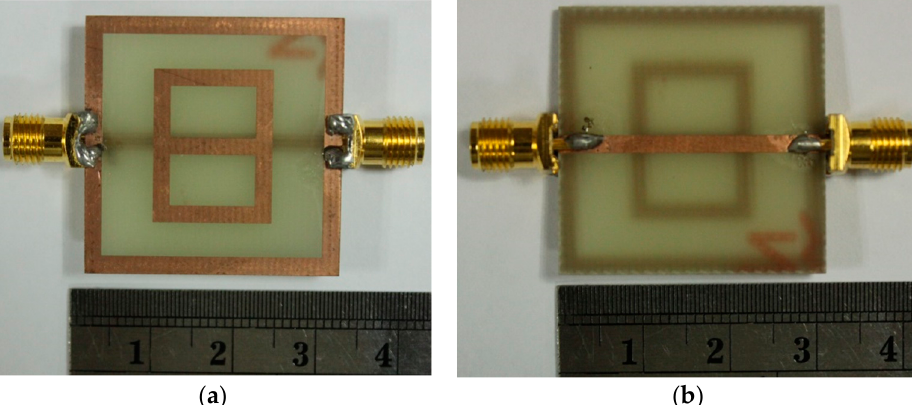
Figure 2. A prototype of the sensor: ( a ) top side, and ( b ) bottom side.